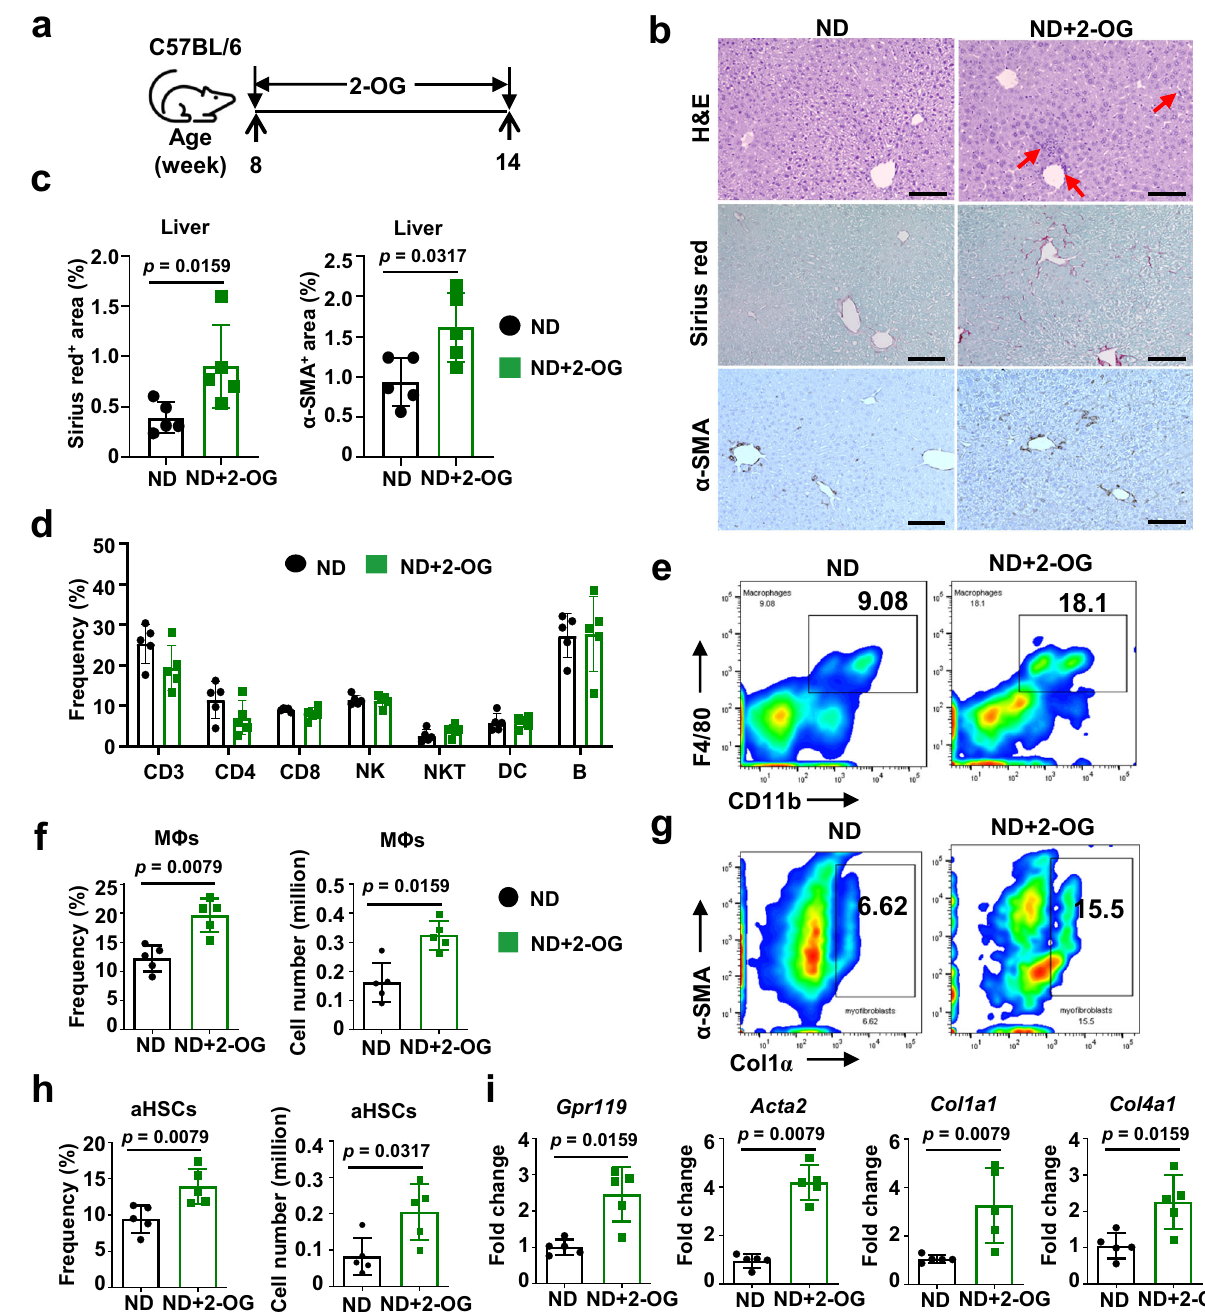
+ CD11c + ), and B cells (CD3 - B220 + ). e Representative frequencies of liver-resident M Φ s in NPCs. Representative fl ow cytometry analysis showed that 2-OG injection caused an increased frequency of liver-resident M Φ s. f Mean frequency (left) and absolutenumber(right)ofM Φ sinNPCsincontroland2-OG-treatedmiceasshown in e . g RepresentativefrequenciesofactivatedHSCsexpressingCol1 α and α -SMAin liver NPCs. Representative fl ow cytometry analysis showed that 2-OG injection caused an increased frequency of activated HSCs expressing Col1 α and α -SMA in liver NPCs. h Mean frequency (left) and absolute number (right) of activated HSCs expressing Col1 α and α -SMAinNPCs incontroland2-OG-treated mice as shownin g . i mRNA expressions of liver Gpr119 and Acta2 . qPCR showed that2-OGinjection ledtotheincreasedmRNAexpressionof Gpr119 , Acta2 , Col1a1 ,and Col4a1 inlivers. n =5,dataarepresentedasmean±SD.Statisticalanalysisofdatawasperformedby Mann – Whitney test (two-tailed) using GraphPad Prism 8 software. Source data are provided as a Source Data fi